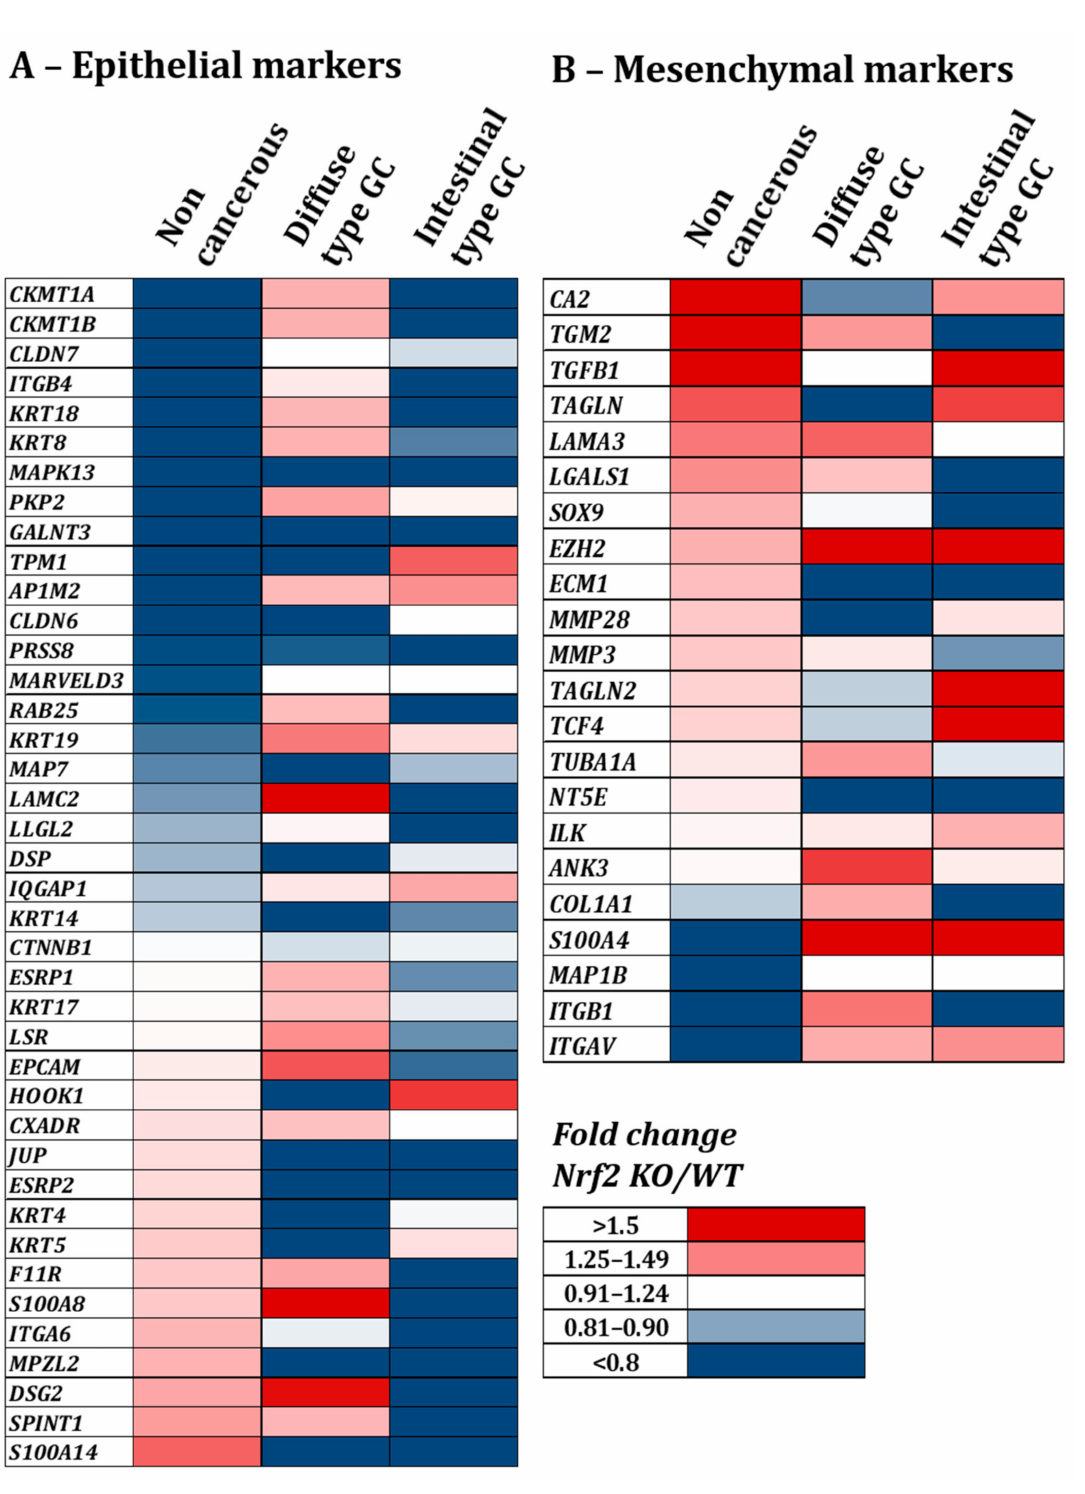
Figure 4. Nrf2 knock-out decreases epithelial and increases mesenchymal proteins in gastric non- cancerous, diffuse cancer or intestinal GC cell lines. Heat map from a proteomic analysis showing fold change between Nrf2-KO and Nrf2-WT for epithelial ( A ) and mesenchymal ( B ) proteins selected from the EMTome database [35]. Proteins were classified in increasing order of the fold change Nrf2-KO/Nrf2-WT of the non-cancerous cell line. n = 3 for each cell